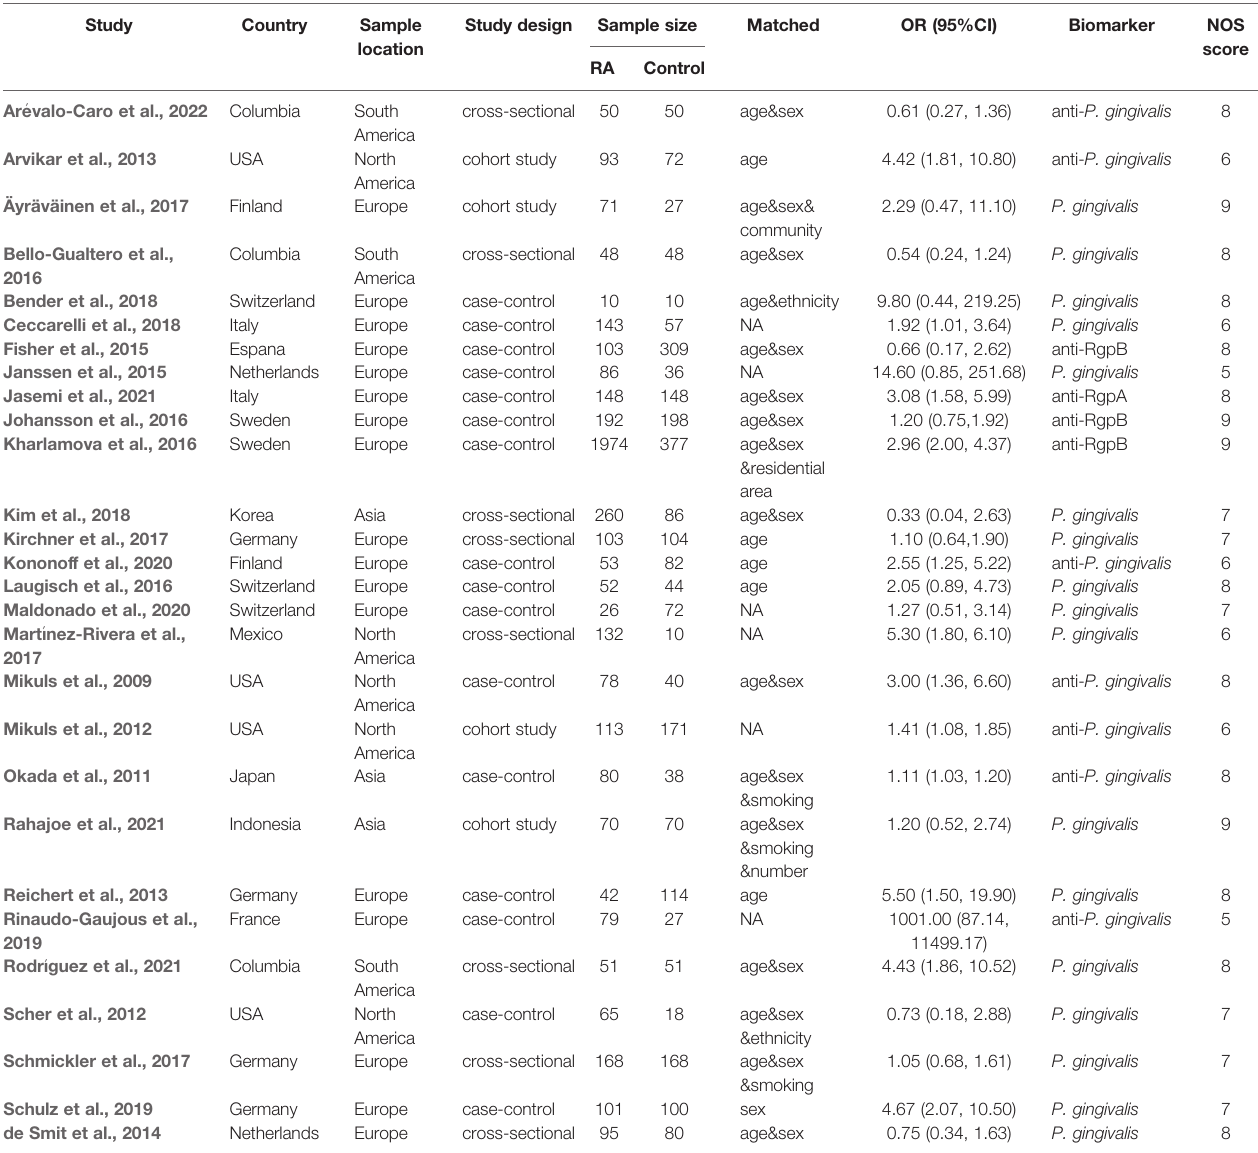
TABLE 1 | Main characteristics of the studies selected for the systematic review and meta-analysis.